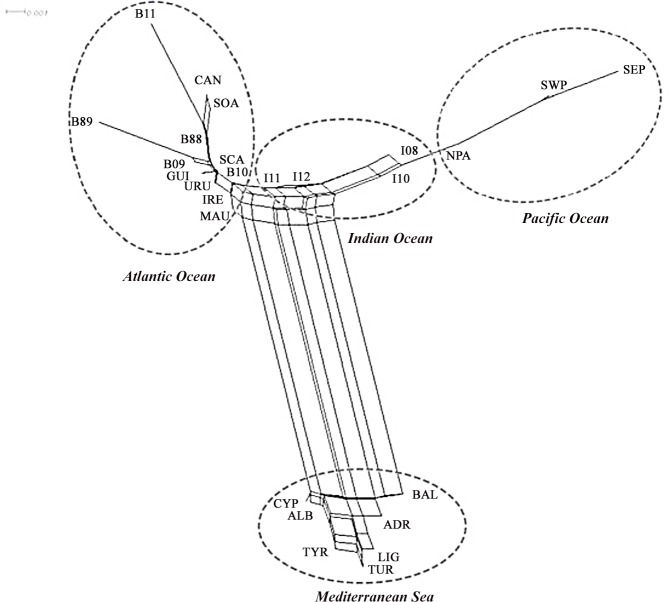
Neighbor-Net dendrogram built from Reynolds distances between 26 samples.Sample abbreviations are as defined in Table 1.